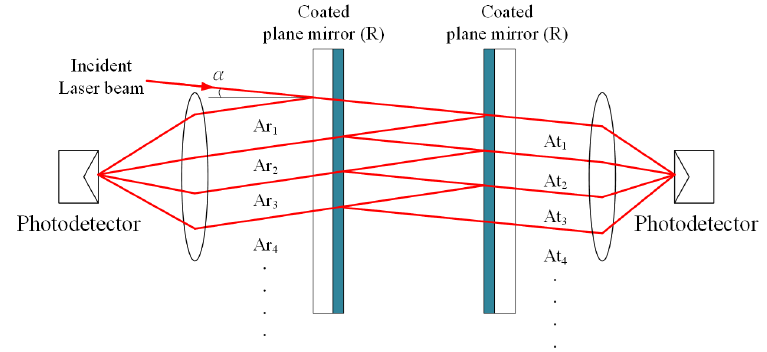
Figure 1. Conventional Fabry–Pérot interferometer